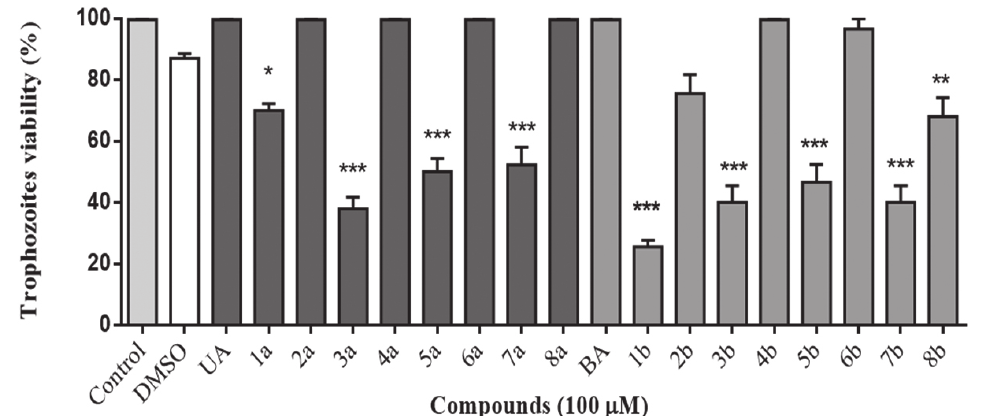
FIGURE 3 – Anti- T. vaginalis activity of UA and BA derivatives. Each bar represents the mean ± standard deviation of at least three independent experiments. Statistically significant differences (p ≤ 0.05) between treated and non-treated groups are indicated by